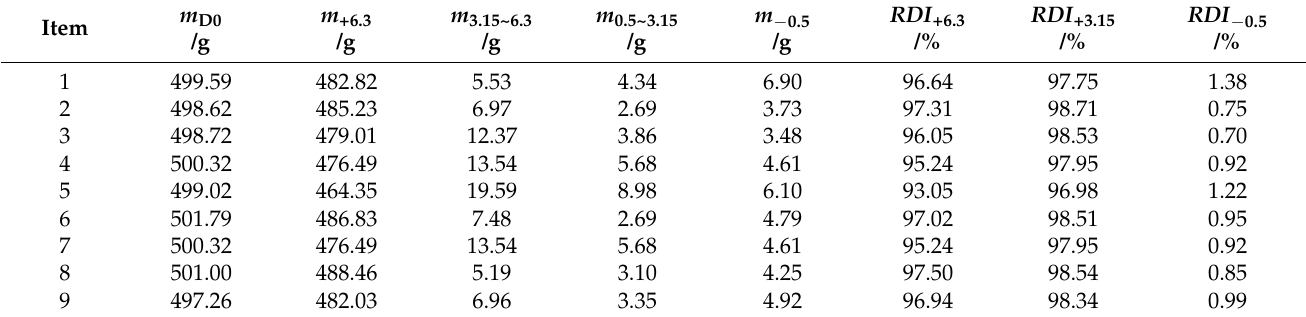
Table 9. Data of low-temperature reduction and pulverization index.